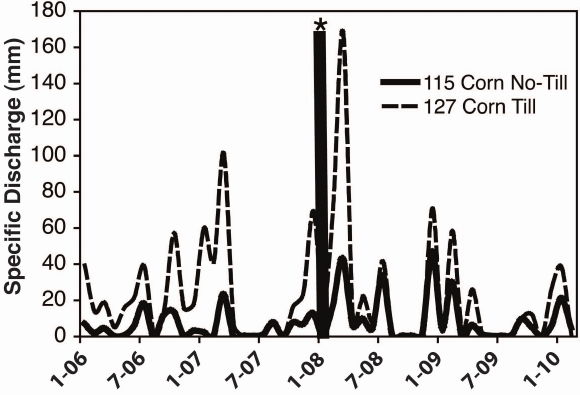
Fig. 4. Monthly discharge (mm) for corn watersheds 115 and 127 during January 2006–February 2010. WS 115 becomes no-till wa- tershed in